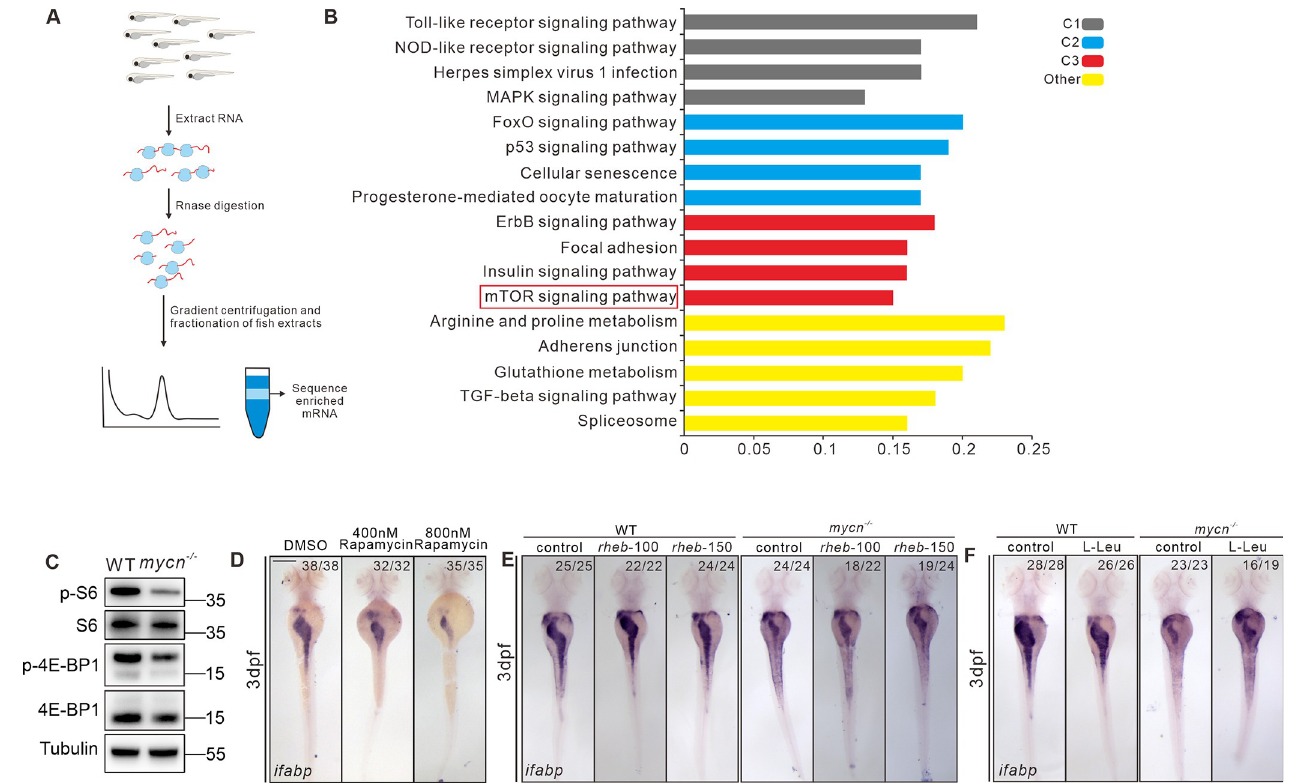
Fig 7. Blockage of mTOR pathway and impaired protein translation results to intestinal defects in mycn mutants. (A) Schematic representation of the experimental workflow of the Ribo-seq. (B) KEGG analysis of the genes showing reduced translation efficiency in the mycn mutant. The red box marks the mTOR pathway. (C) Detection of the rps6, phosphorylated rps6, eIF4EBP, and phosphorylated eIF4EBP in WT and mycn mutant embryos at 3 dpf. The proteins were detected by western blot. The tubulin expression level was used as internal control. (D) Inhibiting the mTOR pathway by different doses of rapamycin mimicked the intestinal defects phenotype of the mycn mutants. (E, F) Activating the mTOR pathway by injecting rheb mRNA and L-Leu treatment partially rescued the intestinal defects phenotype of the mycn mutants. All embryos are shown in dorsal view. Scale bar: 50 μ m ( C ), 200 μ m ( D - F ). Raw images of this figure are provided in S1 Raw Images. dpf, days postfertilization; ifabp , intestine fatty acid–binding protein; WT, wild-type. rps6 and phosphorylated eIF4EBP in mycn mutant (Fig 7C), which further confirmed the